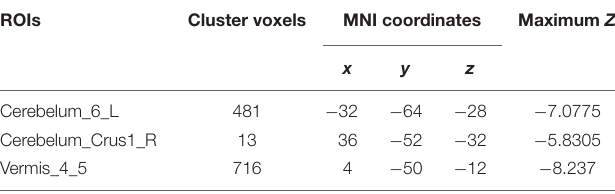
ROIs, regions of interest.